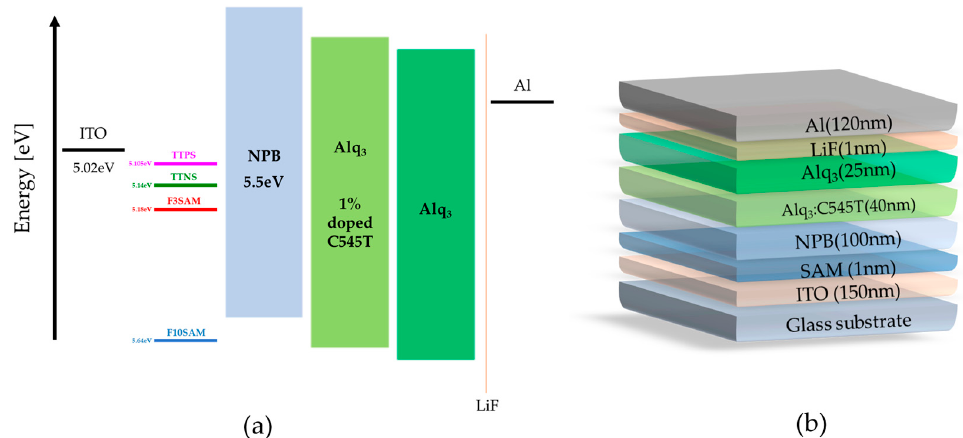
Figure 6. ( a ) Energy levels of the device, ( b ) OLED device structure.